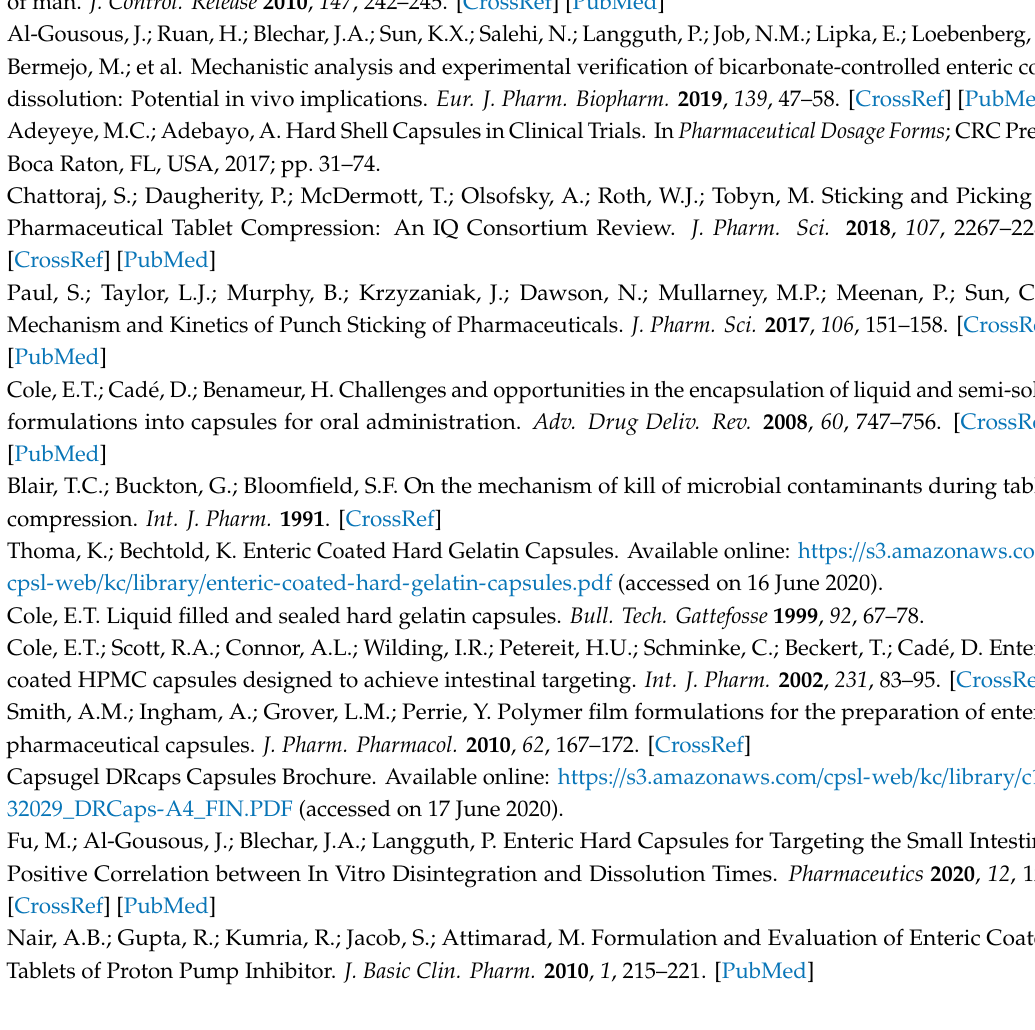
Figure S1: SEM images displaying the surface of the coated capsules. % talc is based on dry polymer weight, Figure S2: Acid uptake of enteric coated HPMC-capsules following incubation in (a) 0.1N HCl or (b) 0.01N HCl. Horizontal line represents 10 % acid uptake. Given are average acid uptake (%) ± SD; n = 6. % TEC and % talc are based on dry polymer weight., Figure S3: Acetyl- and succinoyl content of the di ff erent